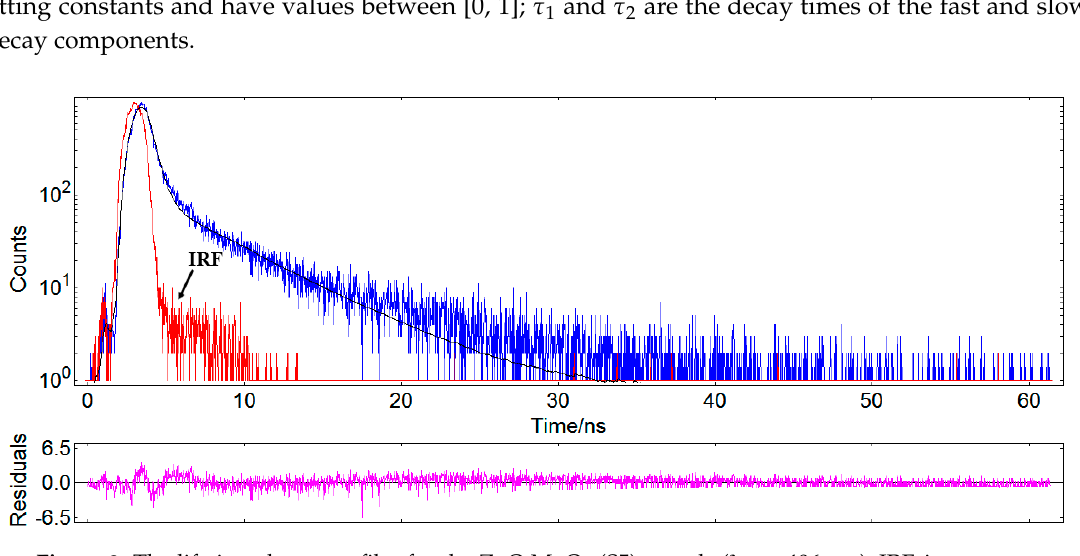
Figure 8. The lifetime decay profiles for the ZnO:MoO 3 (S5) sample ( λ ex = 406 nm); IRF, instrument response function.